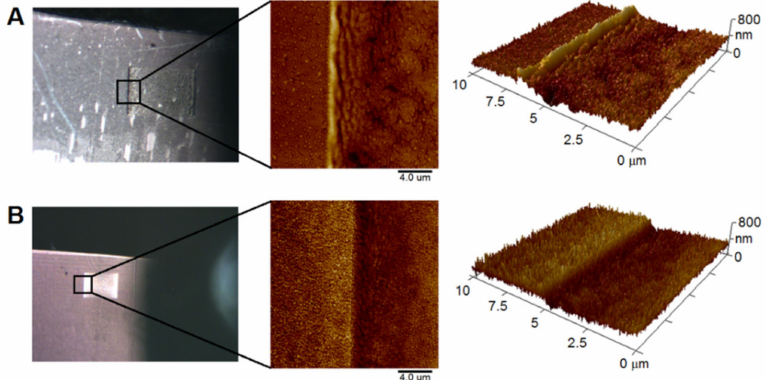
Figure 6. The interface of PET ( A ) and PEEK ( B ) surfaces with optomechanically processed AgNPs after their irradiation with an SC laser. From the left: image from the auxiliary AFM camera; 2D and 3D AFM scans (scan sizes of 10 µ m).